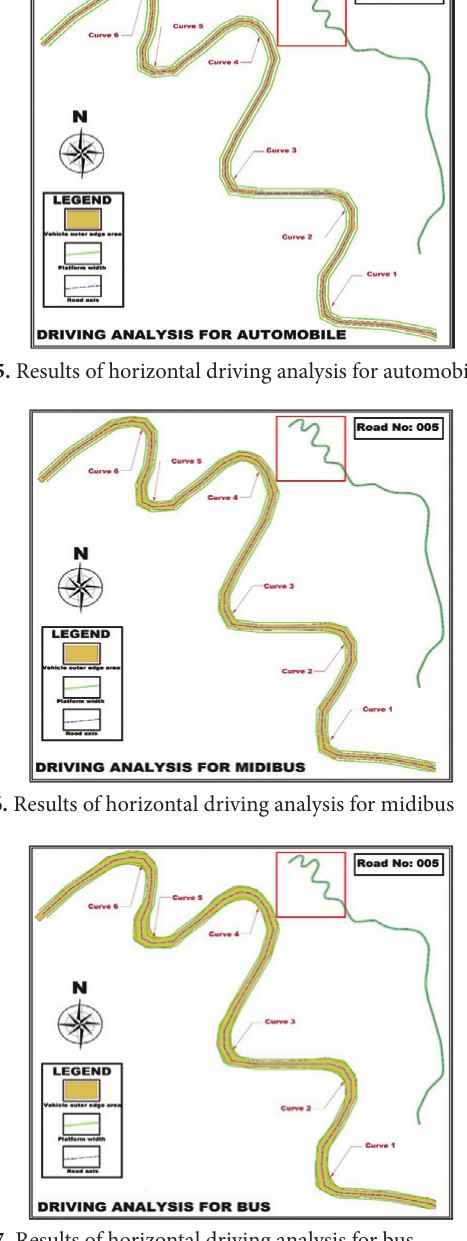
Fig. 7. Results of horizontal driving analysis for